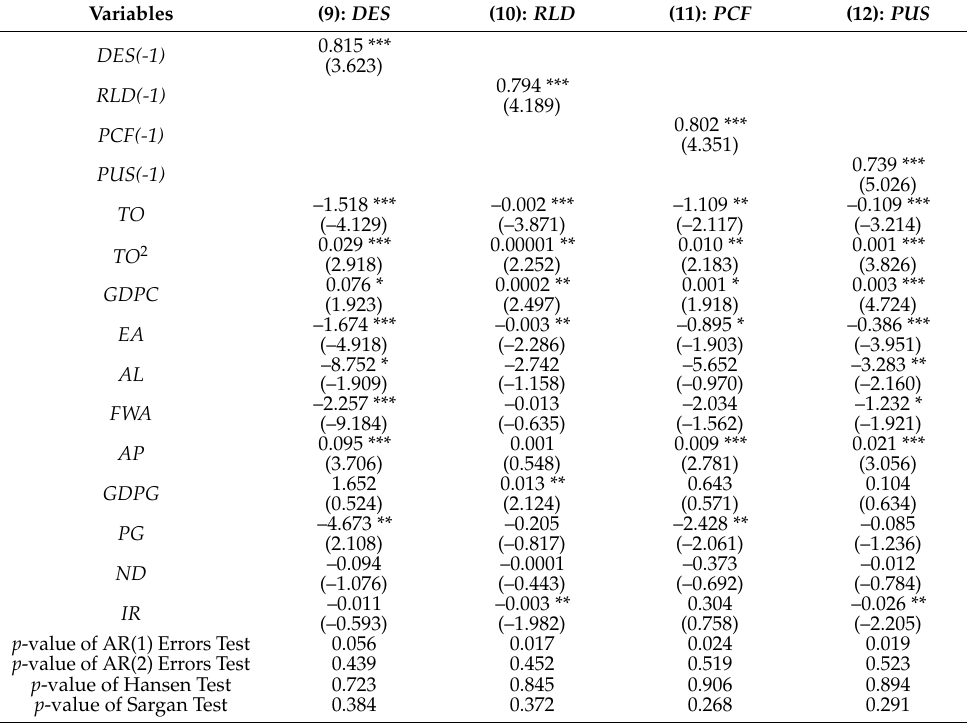
Table 7. Estimation results of DPD analysis with GMM